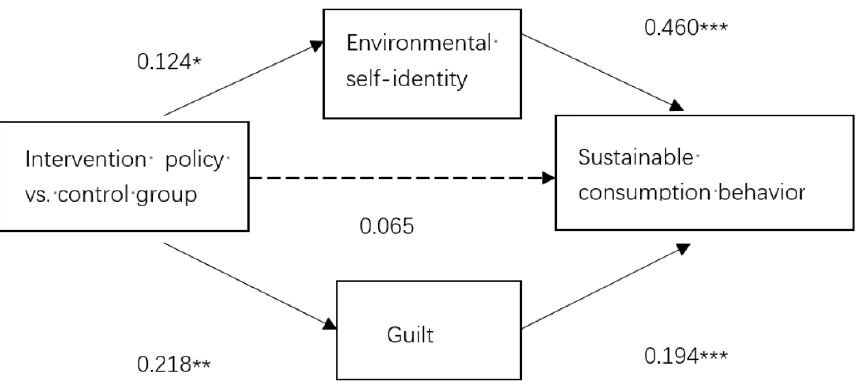
Figure 2. Influence of regulatory policy on sustainable consumption behaviour through the media ‐ tion of environmental self ‐ identity and guilt. *** p < 0.001, ** p < 0.01, * p < 0.05. The assignment for regulatory policy: penalty policy = − 1; control = 0; voluntary participation policy = 1. A continuous line specifies a significant relationship. A dotted line indicates that the relationship is not significant at the 5% level (one ‐ sided for β‐